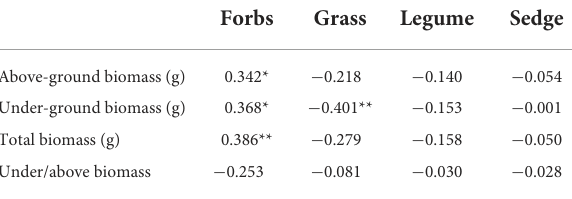
TABLE 2 Changes in different diversity